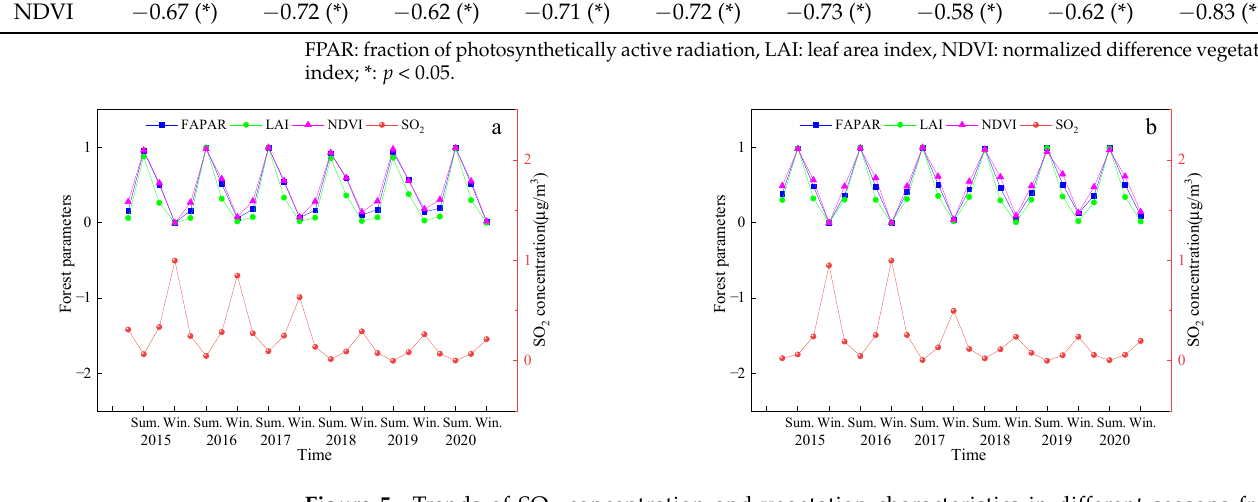
Figure 5. Trends of SO 2 concentration and vegetation characteristics in different seasons from 2015– 2020 (( a ). Changchun, ( b ). Baishan).